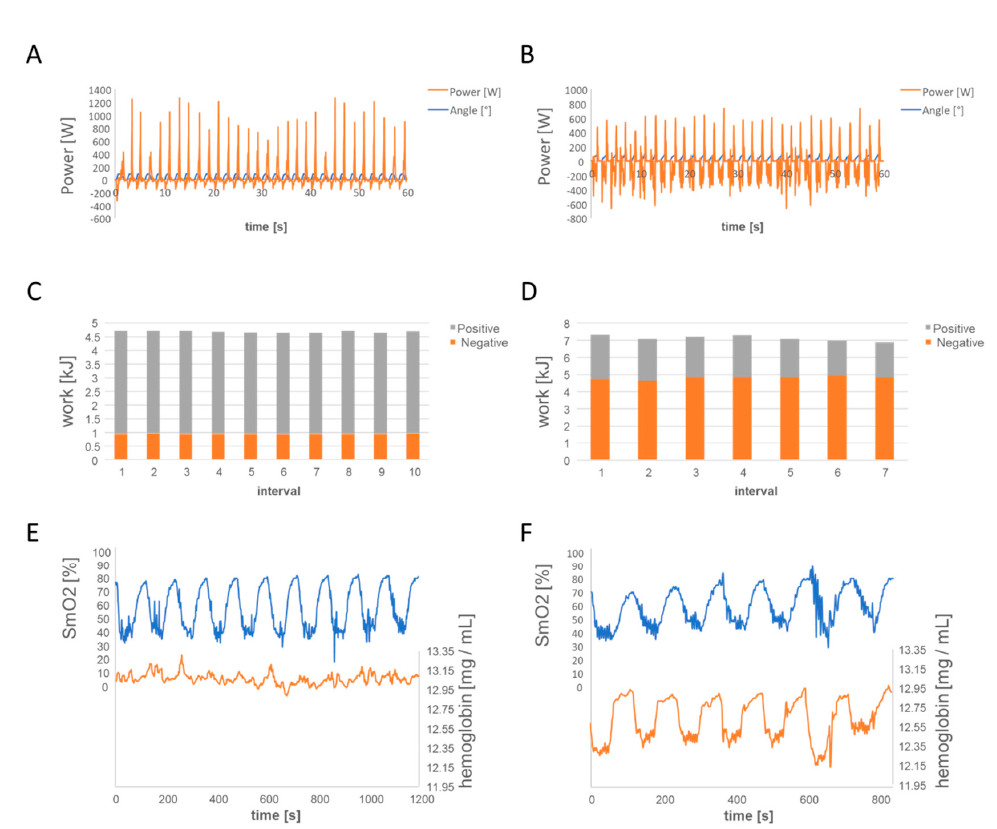
Figure 1. Power output and muscle oxygen saturation during workload-matched concentric and eccentric type of interval exercise. ( A , B ) Example of the power output being produced by one subject during one interval of concentric ( A ) and eccentric ( B ) interval exercise, respectively, before training. ( C – F ) Positive and negative work being performed by the left leg of one subject during all intervals of a session of concentric ( C ) and eccentric ( D ) interval exercise and the resulting effects on muscle oxygen saturation and hemoglobin concentration in m. vastus lateralis ( E , F ) for one leg before training.